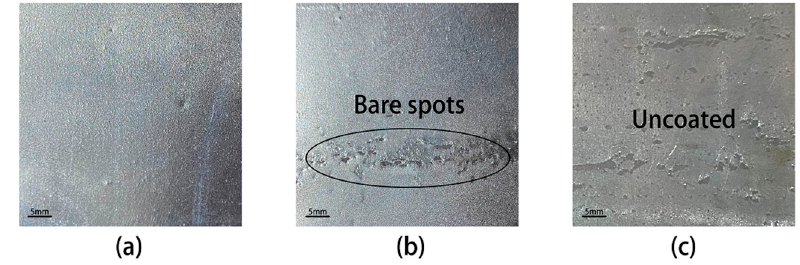
Figure 2. Surfaces of hot-dip galvanized samples annealed at different temperatures. ( a ) 1# (873 K), ( b ) 3# (923 K), ( c ) 5# (1093 K).